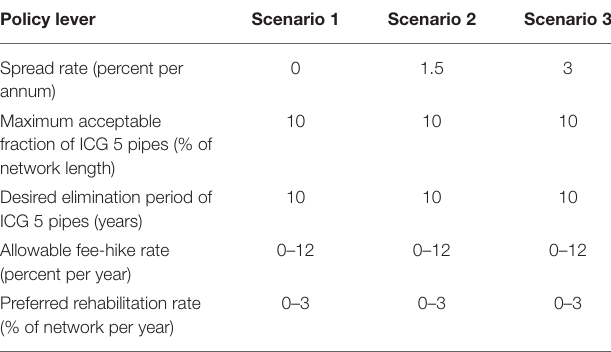
TABLE 5 | Policy levers for three scenario